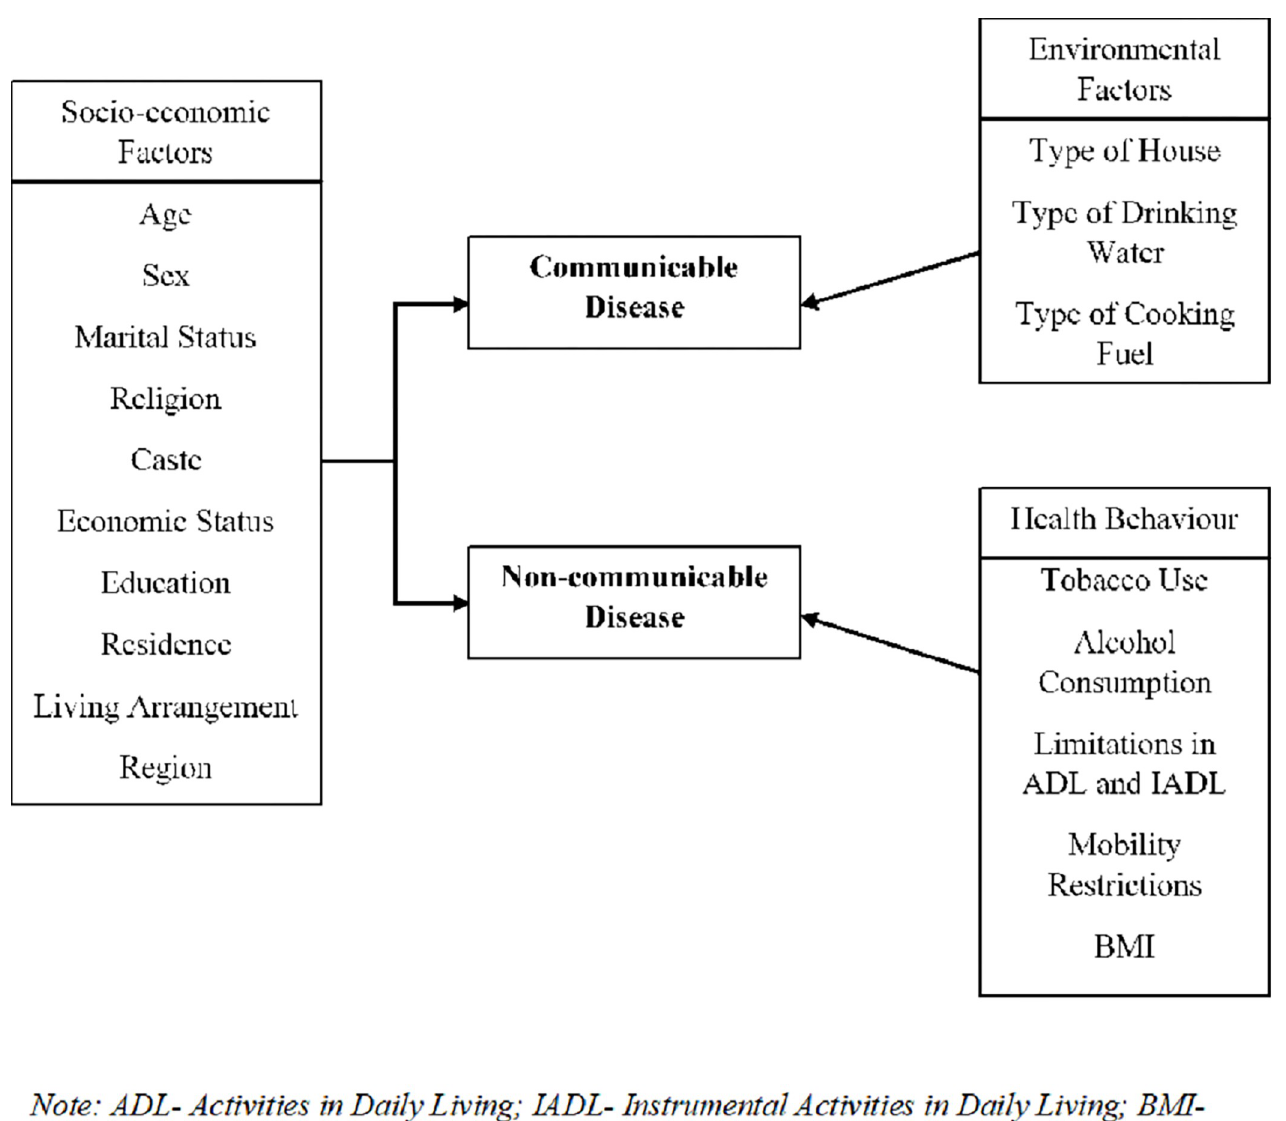
Fig 1. Theoretical